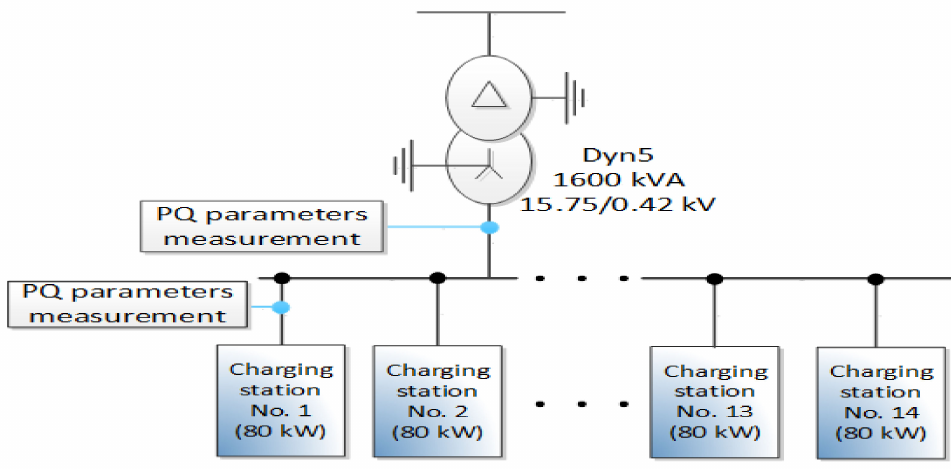
Figure 1. The view of ( a ) the bus depot and dedicated substation at the Grygowa Street; ( b ) Solaris Urbino Electric 12 electric bus being charged with the fast charger.